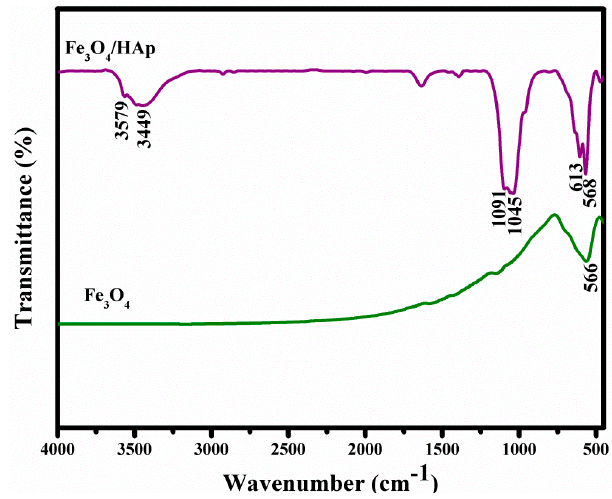
Figure 2. Fourier transform infrared spectroscopy (FTIR) spectra of Fe 3 O 4 nanoparticles and Fe 3 O 4 /HAp nanocomposites.